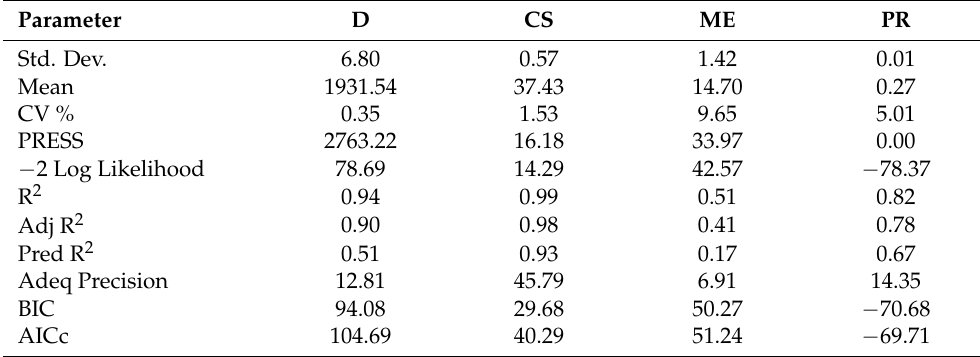
Table 4. Model validation parameters.